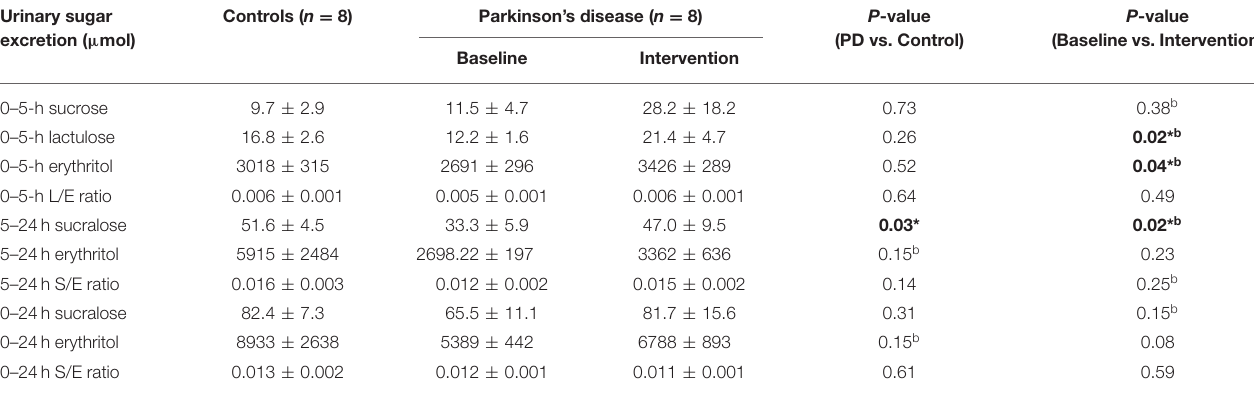
TABLE 3 | Markers of intestinal permeability at baseline and after a 5-week Mediterranean diet intervention a .